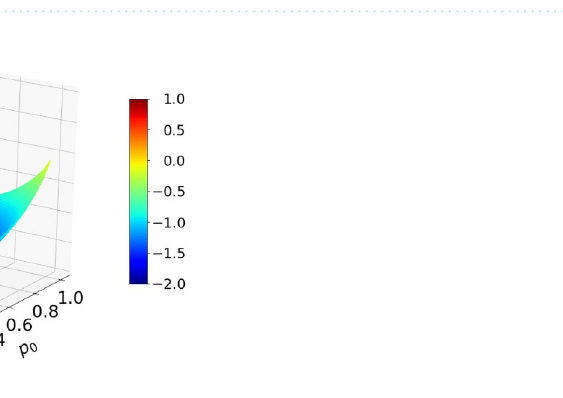
Figure 18. Measured transfer function (a) ; and errors (difference from the ideal division) (b) for the circuit SUB1, for a fixed value of p 1 = 0.3 and counter capacities of N = 2, 4, 6 and 8 bits. The results are equal for the improved circuit SUB2.